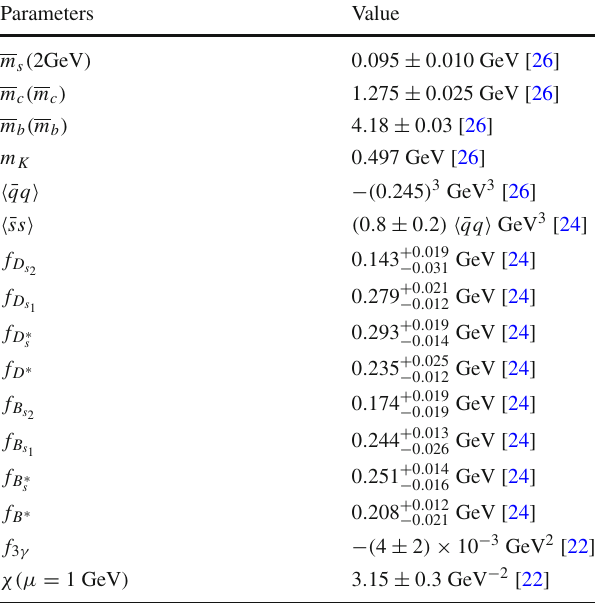
Table 1 The values of the input parameters used in our calculations